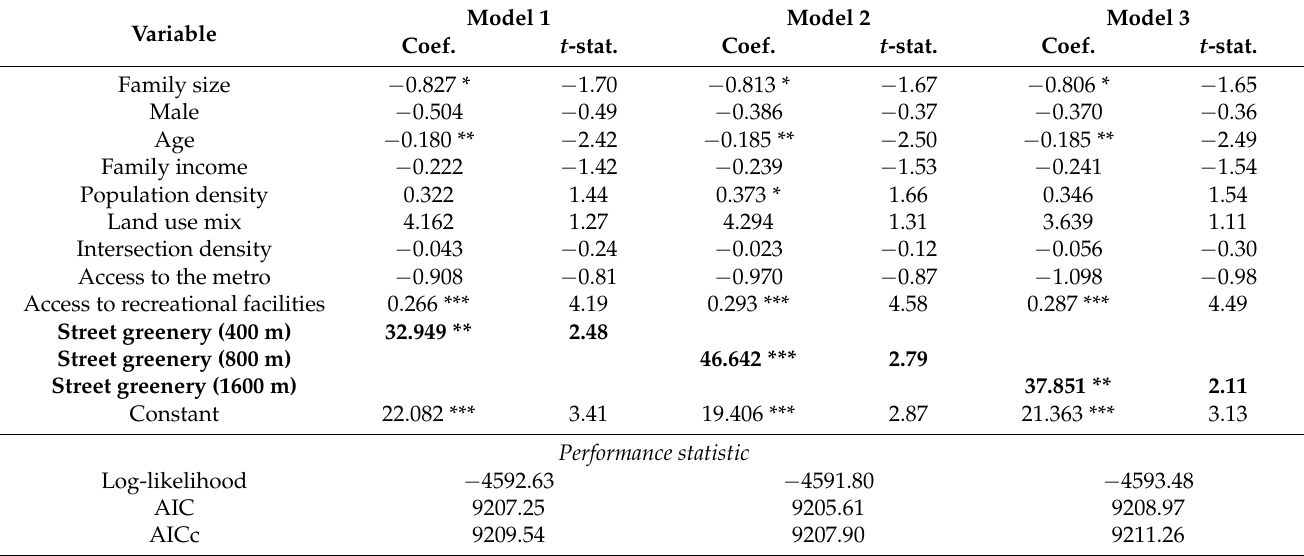
Table 2. Linear regression modeling